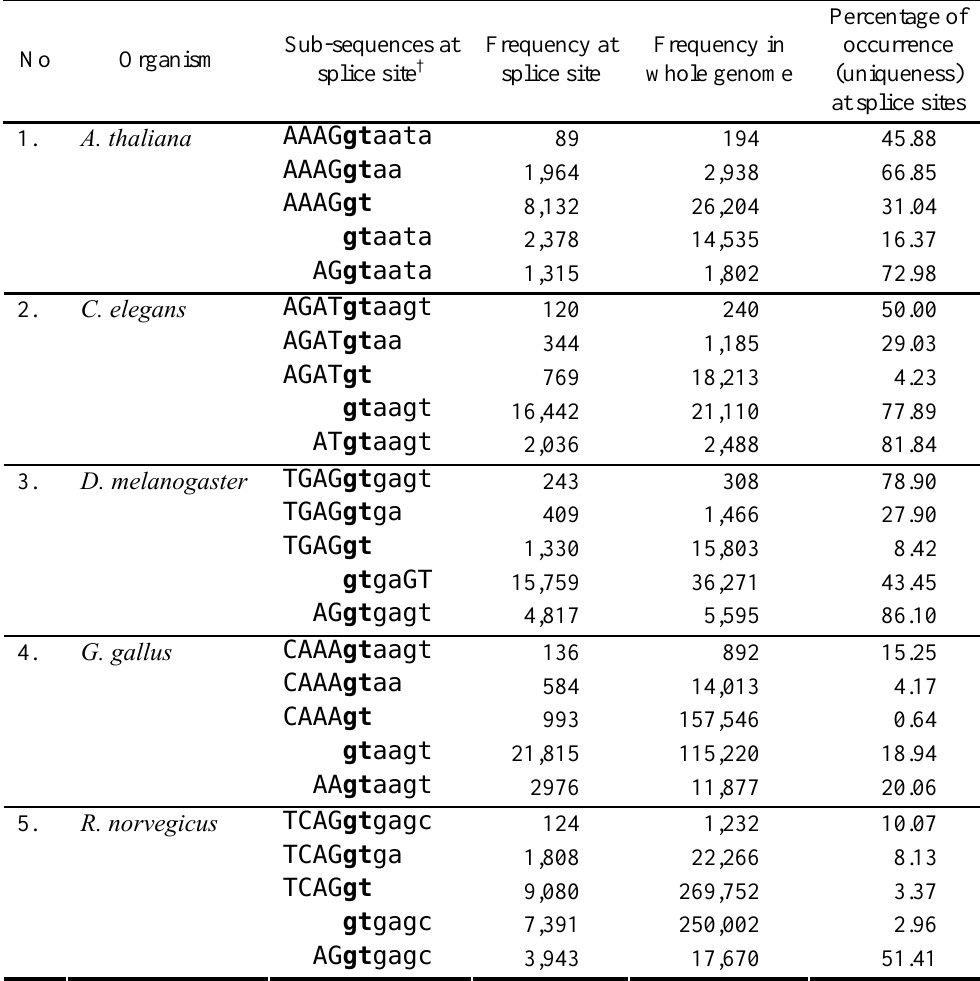
Table 6a. Percentage of occurrence (uniqueness) of different sub-sequences (with medium frequency) of size ten at the donor splice site region and the whole genome of the